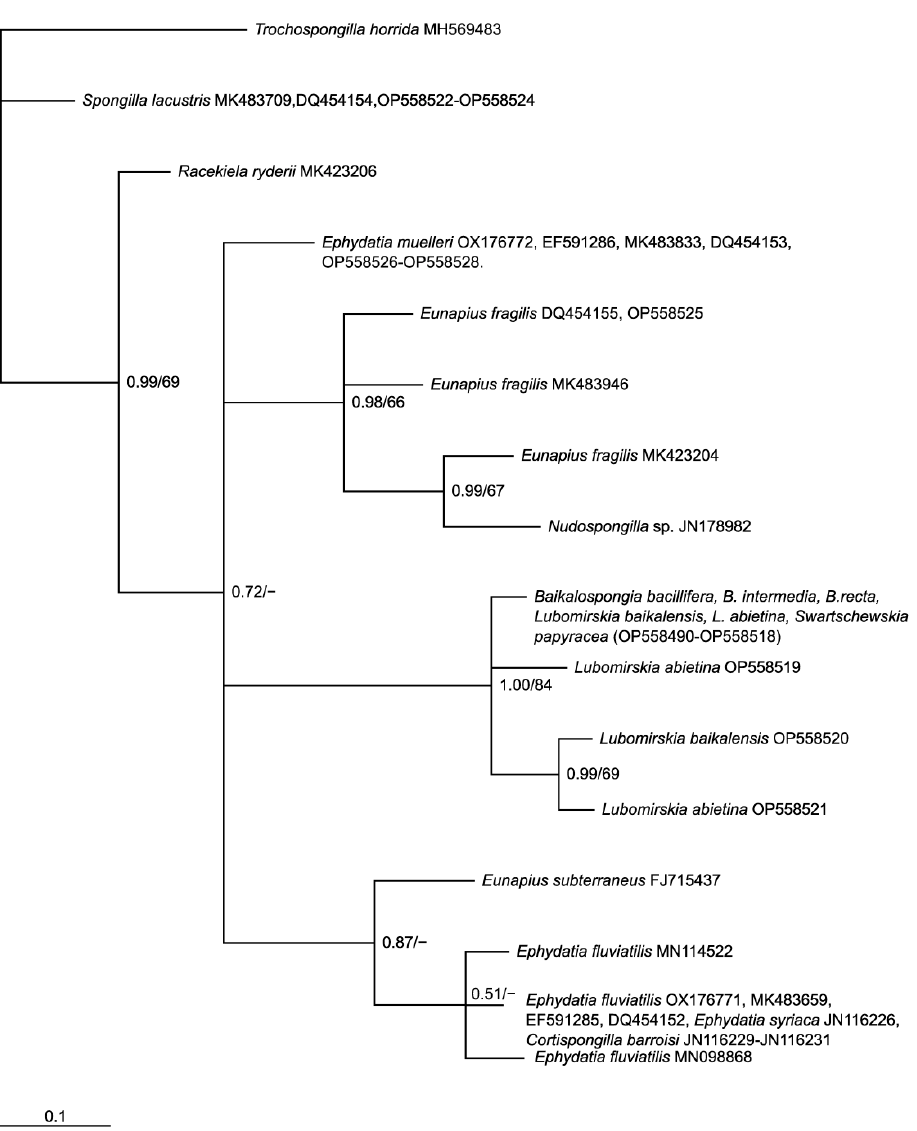
Figure 4. Bayesian phylogenetic tree based on comparisons of 287 bp of 28S rDNA sequences of Spongillida. Nodes are characterized by Bayesian posterior probabilities (PP > 0.50) followed by bootstrap percentages (ML; bp > 50%). Trochospongilla horrida (Spongillidae; GenBank MH569483) was used as the outgroup. Scale bar indicates substitutions per site at unit distance.